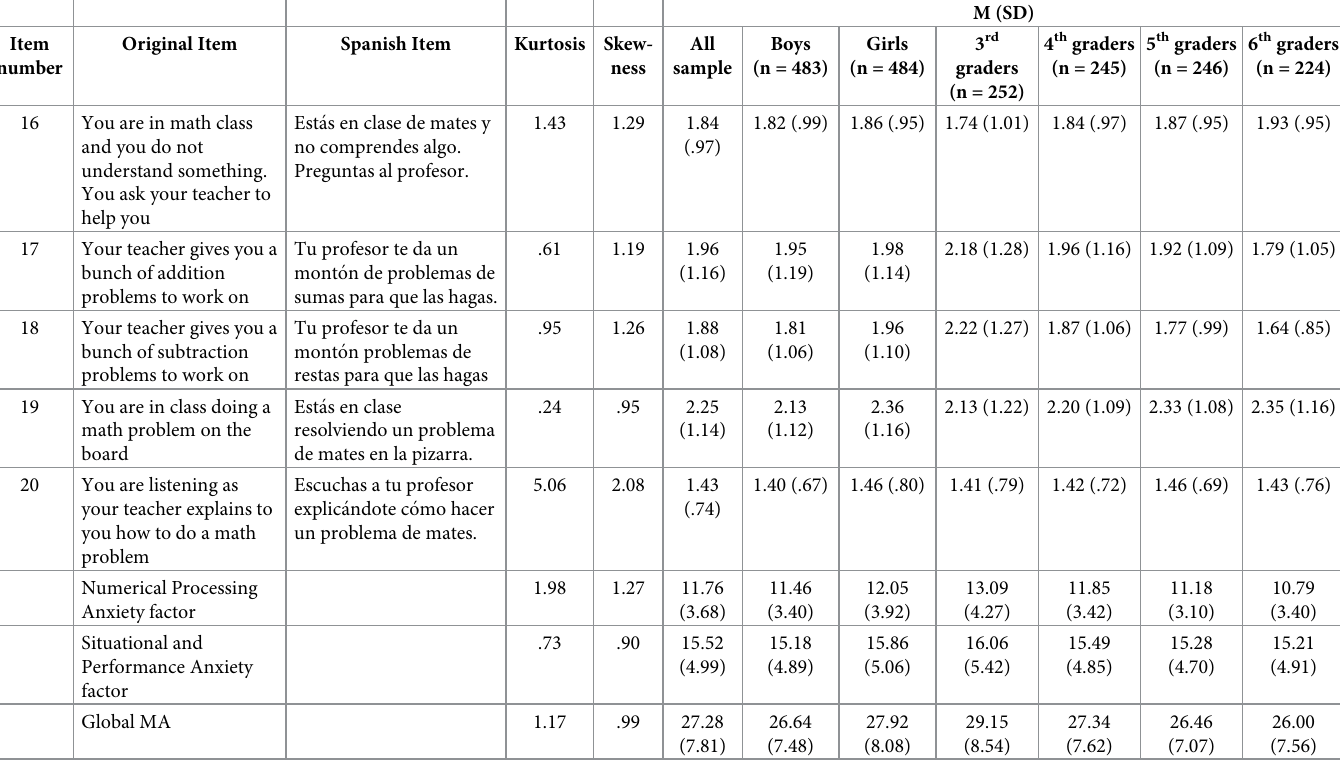
results indicated that grade and gender explained 5.7 and 0.7 of the numerical processing anxi- ety factor, respectively. For the grade factor, the analysis indicated that the third graders ( M = 13.09, SD = 4.27) exhibited higher MA than the fourth ( M = 11.85, SD = 3.42, p = .001), fifth ( M = 11.18, SD = 3.10, p < .001), and sixth graders ( M = 10.79, SD = 3.40, p < .001). Moreover, the fourth graders also reported higher MA than the sixth graders ( p = .008). Regarding gender, the girls ( M = 12.05, SD = 3.92) scored higher in MA than the boys ( M = 11.46, SD = 3.40; with Cohen’s d = .16, meaning a small size effect. Regarding the situational and performance anxiety factor, the ANOVA revealed that there was neither a significant main effect of grade, F (3,959) = 1.52; p = .207, η p2 = .005 nor a grade by gender interaction, F < 1. However, the main effect of gender was significant, F (1,959) = 4.79; p = .029; η p2 = .005. The results revealed that gender explained 0.5% of the subscale scores, with the girls ( M = 15.86, SD = 5.06) scoring higher in MA than the boys ( M = 15.18, SD = 4.89; Cohen’s d = .14, indicating also a small size effect). Finally, following the suggestion of Ganley and McGraw [33], trait anxiety was introduced as a covariate. ANCOVAs indicated that there were significant main effects of grade for global MA, F (3,957) = 9.64; p < .001; η p2 = 2 = .066, .029, and for the numerical processing anxiety factor, F (3,957) = 22.44; p < .001; η p but not for the situational and performance anxiety factor, F (3,957) = 1.54; p = .175; η p2 = .002. In the case of gender, there were no significant differences in global MA, F (3,957) = 3.40; p = .066; η p2 = .004, either for the numerical processing anxiety factor, F (3,957) = 3.83; p =